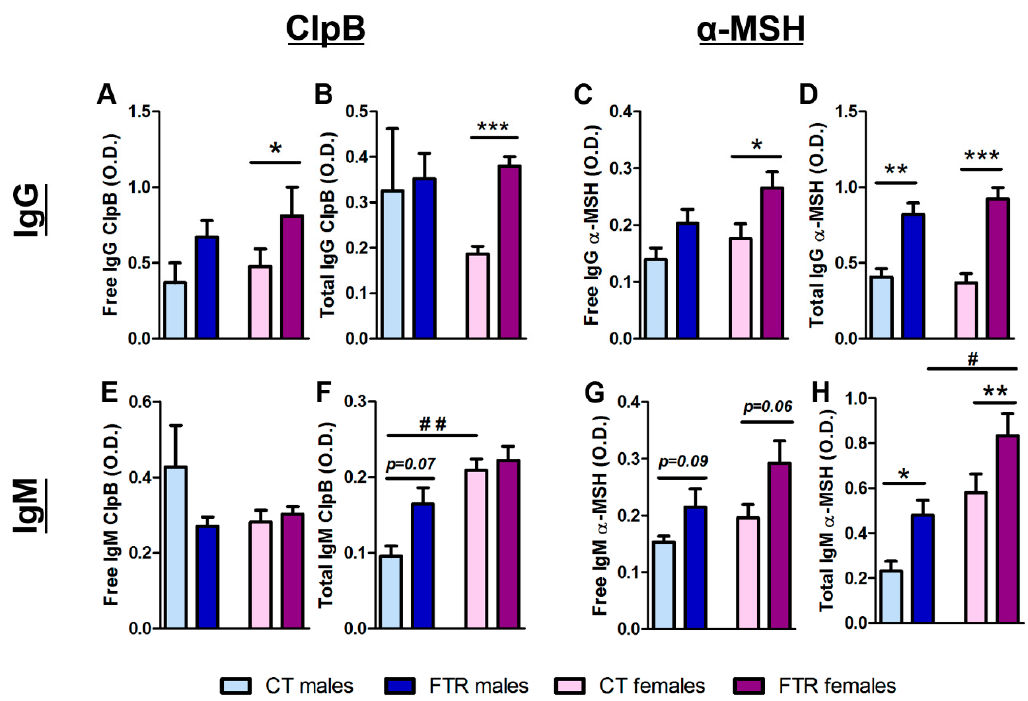
Figure 3. Effects of food restriction on ClpB- and α -MSH-reactive immunoglobulin production. ClpB- ( A , B , E , F ) and α -MSH-( C , D , G , H ) reactive free and total IgG ( A – D ) and IgM ( E – H ) before (CT) and after 14 days of feeding time restriction (FTR) in male (light and dark blue, left side of each panel) and female (light and dark pink, right side of each panel. A – D,F,H , Students t-test * p < 0.05, ** p < 0.01, *** p < 0.001, 1-way ANOVA, Bonferroni’s post-test # p < 0.05, ## p < 0.01.